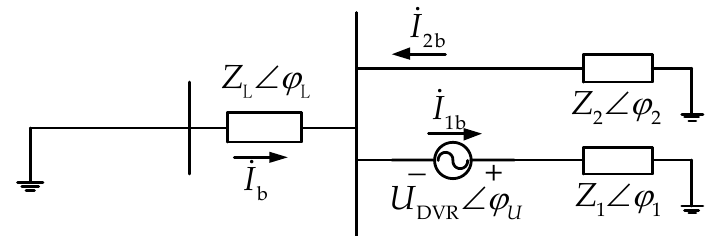
Figure 3. Equivalent circuit when the system source acts alone;  , I I are the currents of the sensitive load and the adjacent load respectively voltage sag occurs,   1 2 without DVR after voltage sag,  I is the current supplied by the system source to the loads after voltage sag.